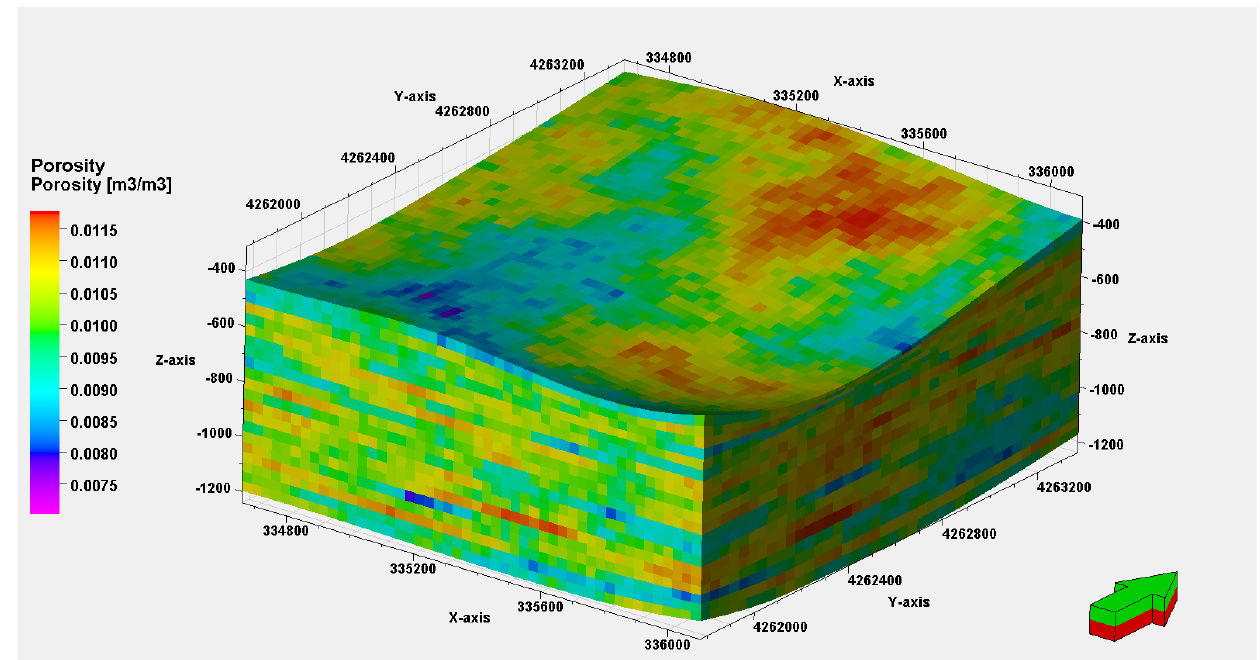
Figure 5. Recreated model of the Milford area subsurface. Faults are represented by purple and pink planes. Yellow box is a representation of the EGS system location (the simulation model) and is limited from the top and bottom by two temperature profiles 175 (blue) and 225 °C (red) isotherms. Remaining surfaces represent respectively from the top: the Earth surface (with a highlighted exact location of the Utah FORGE site in red) and the top of granitoid formation in light green.